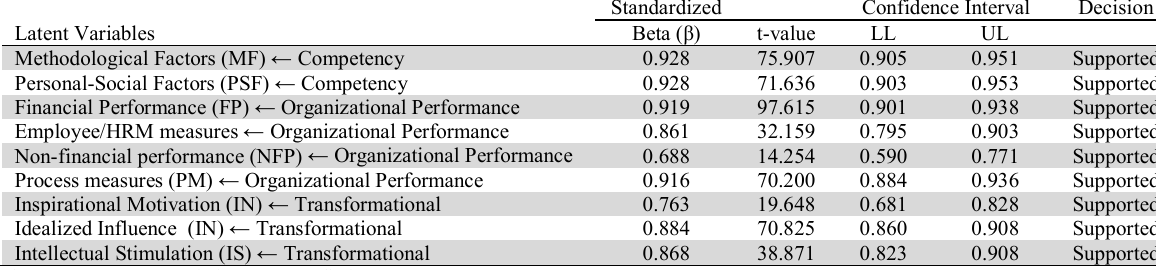
The Summary of Bootstrapping Result of Path Coefficient